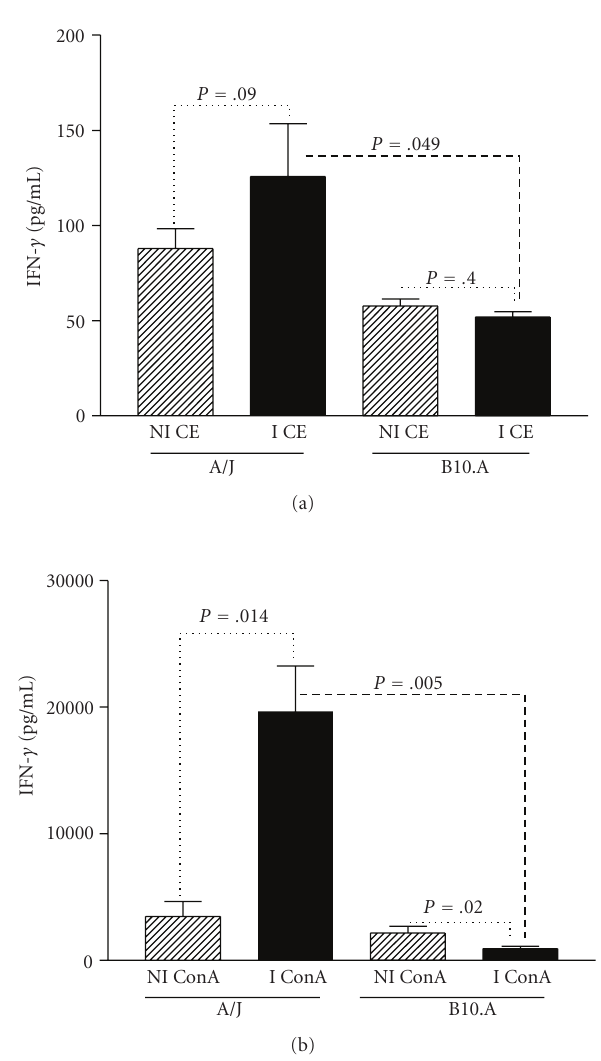
Figure 5: Level of IFN γ in the culture supernatant of spleen cells from A/J and B10.A mice nonimmunized (NI) and immunized (I) with the crude extract of L3 larvae of Lagochilascaris minor , stimulated with (a) ConA or (b) CE. Spleen cells were stimulated in vitro and the supernatant was collected after 48 hours. Cytokine production was considered positive if over the detection limit of 15pg/mL for IFN γ . Bars represent the mean values ±